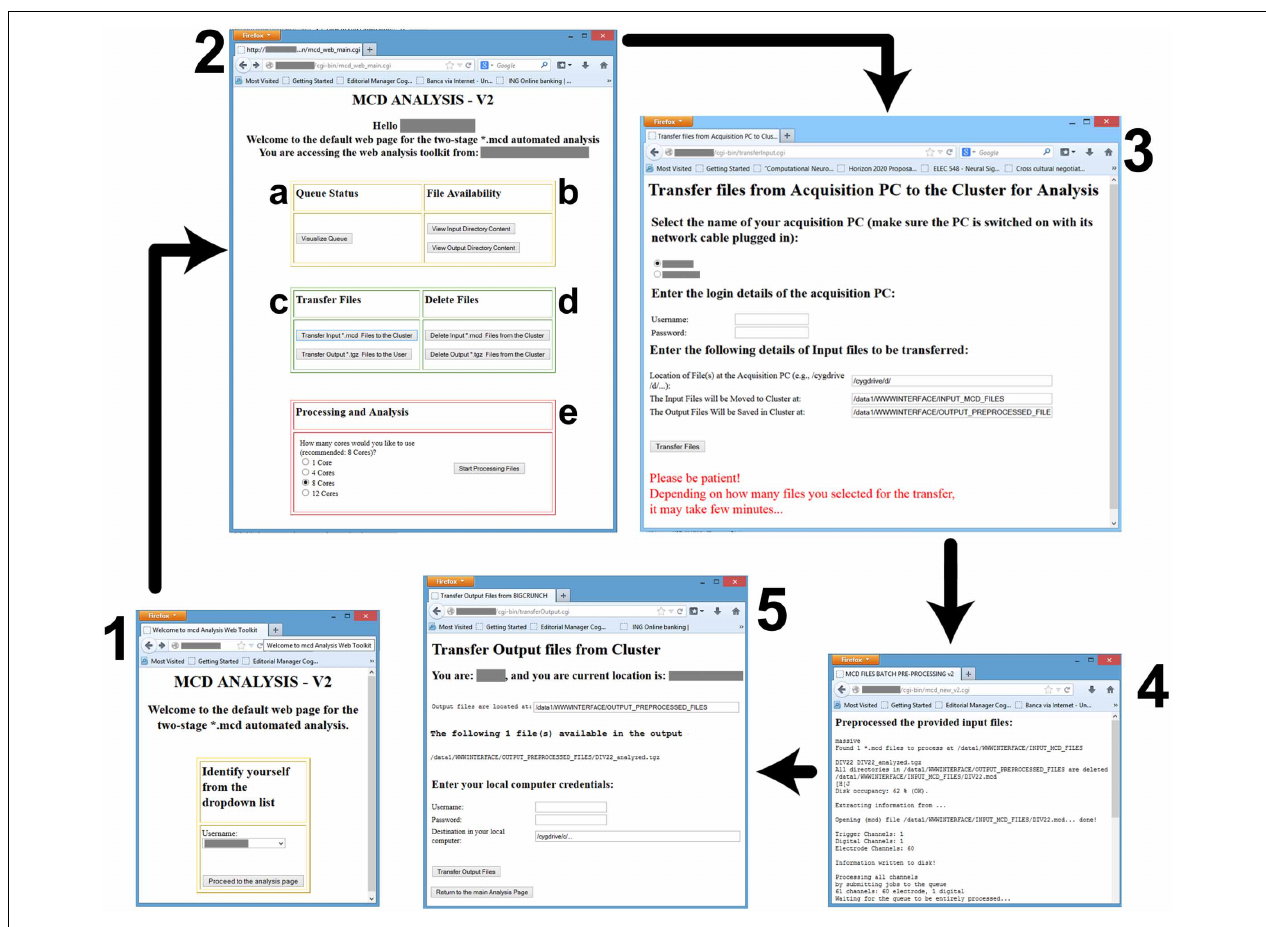
FIGURE 4 | Screenshots of the web-interface. Each window is numbered to denote a separate stage of the workflow, and consist in: (1) the user-identification; the (2) main control webpage; the (3) file transfer interface from the data acquisition PC to the master node; (4) the result of the preprocessing; and (5) the file transfer from the master node to the user PC.